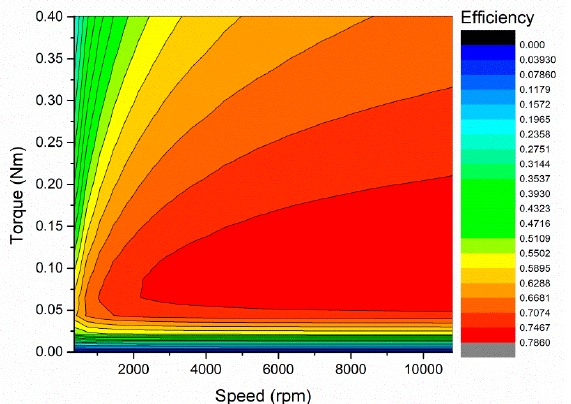
Figure 13. Efficiency map.